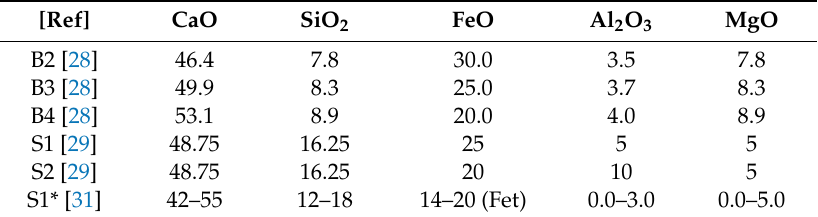
Table 4. Chemical composition (in mass%) of the reference slags from Figure 3.